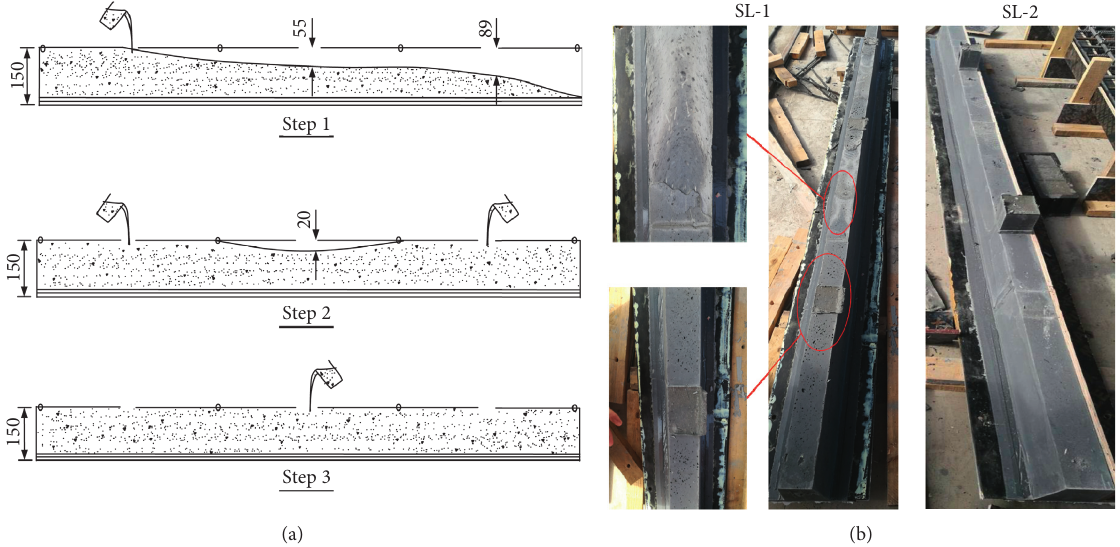
Figure 8: Self-levelling grouting: (a) grouting process; (b) grouting